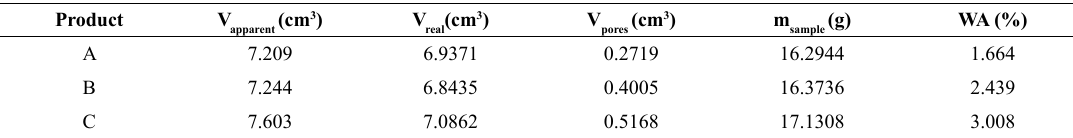
Table 6. WA values obtained from the modified picnometry method.